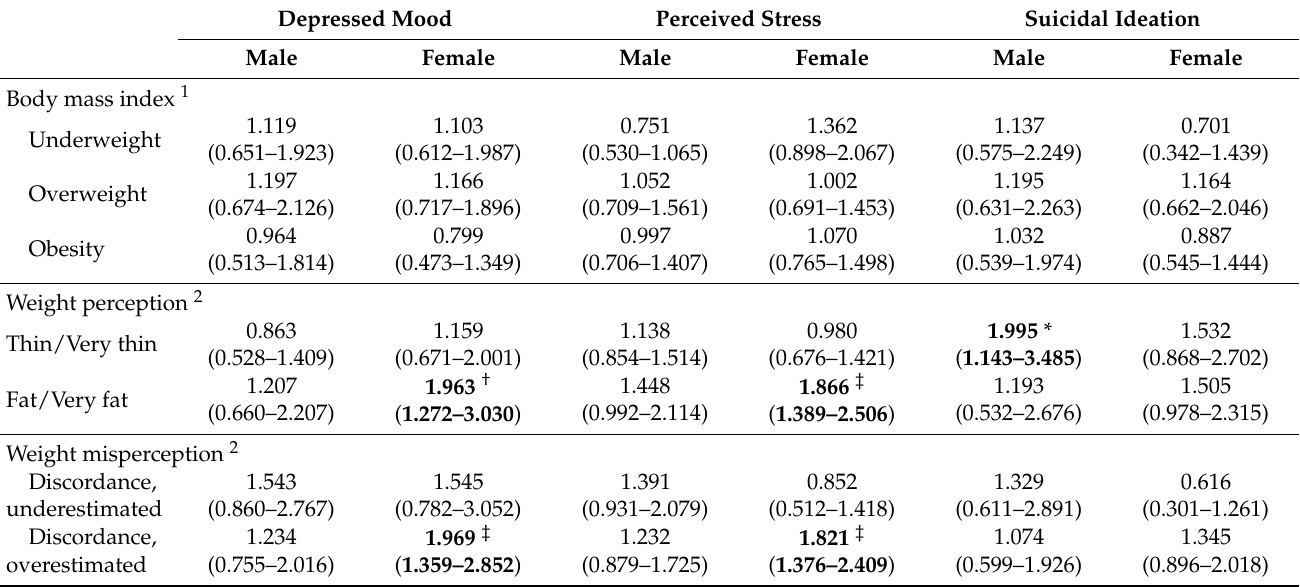
Table 2. Associations between body weight status and mental health